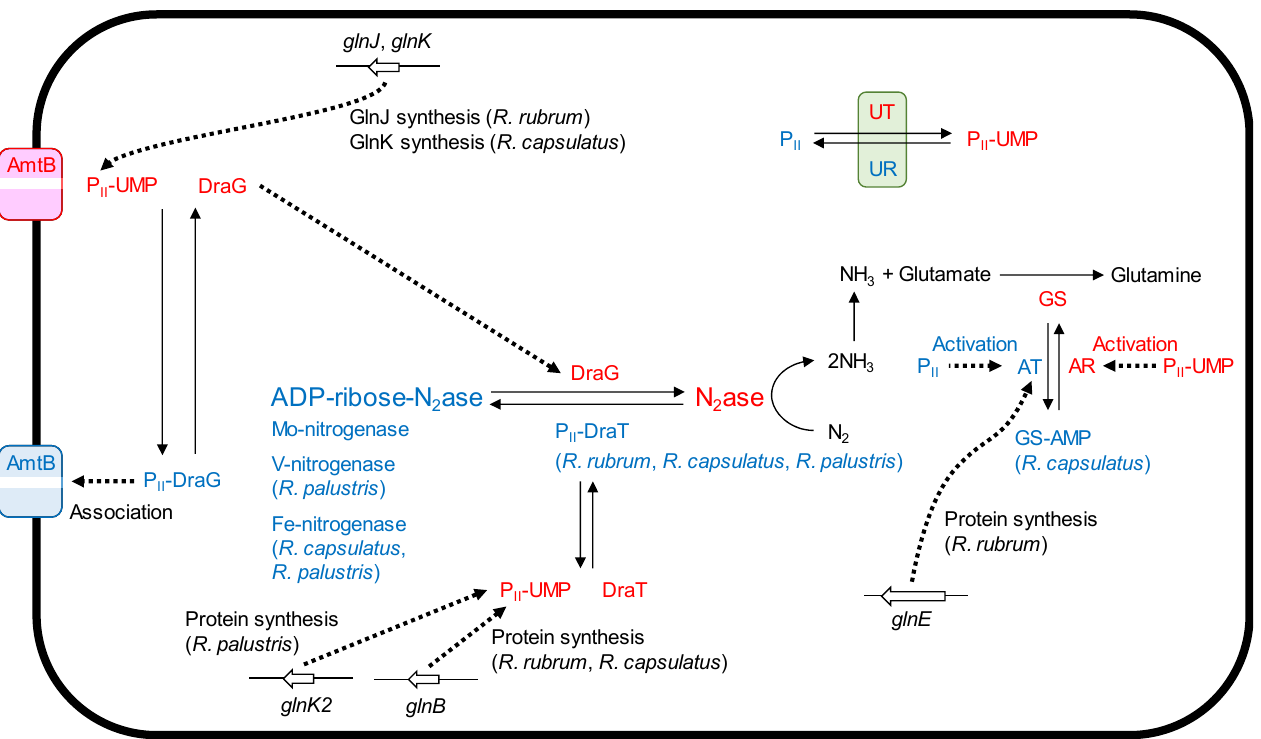
Figure 2. Post-translational regulations of nitrogenase and GS activities in PNSB. Protein designa- tions and biochemical responses with red and blue colors mean their states under ammonia-defi- cient and ammonia-sufficient conditions or with light irradiation and darkness, respectively. UR (uridyl removing enzyme) and UT (uridyltransferase) activities are controlled by nitrogen status (2- oxoglutarate/glutamine) [64] . N 2 ase, nitrogenase; AT, adenylyl transferase; AR, adenylyl-removing enzyme.